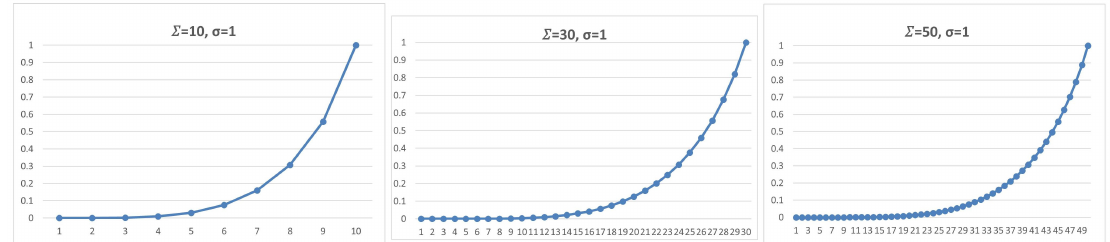
Figure 14. Relation between the number of packets the adversary manipulates and the probability π NA of the receiver not holding the authenticated status for a sender.